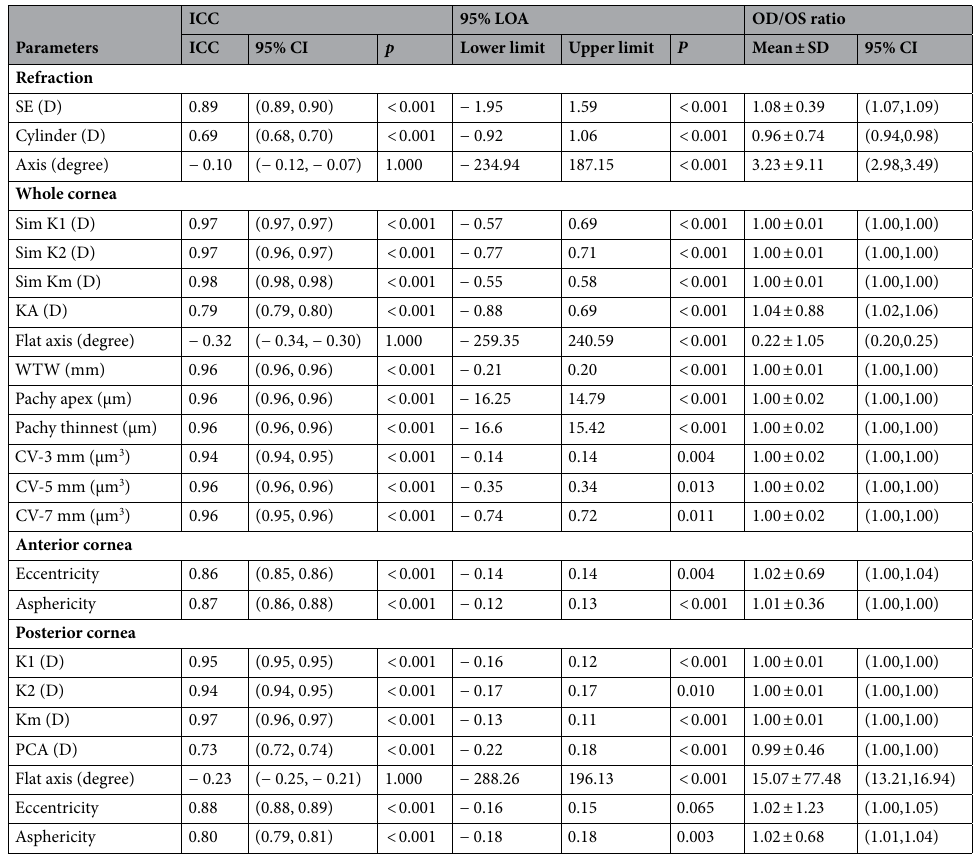
Table 3. Summary of the ICC and LOA between the both eyes and the right-to-left ratio in different corneal biometrics. ICC intraclass correlation coefficient; LOA limit of agreement; CI confidence interval; SD standard deviation; SE spherical equivalent; D diopter; KA keratometric astigmatism; WTW white-to-white; CV corneal volume; PCA posterior corneal astigmatism.